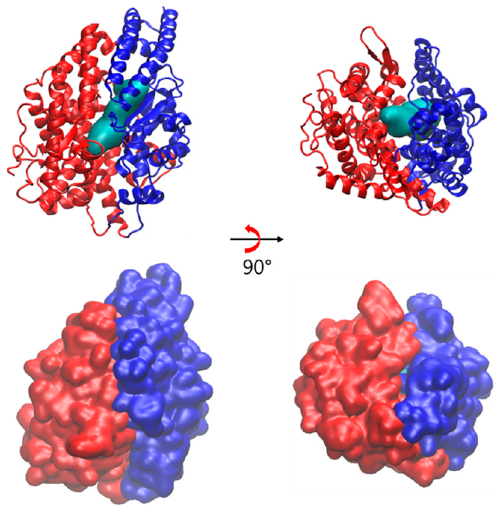
Figure 6. Surface representations of AngII (cyan colored) and ribbon representation of a closed state of sACE (subdomain I in blue and subdomain II in red) at the top panel and its surface representations of sACE at bottom panel.